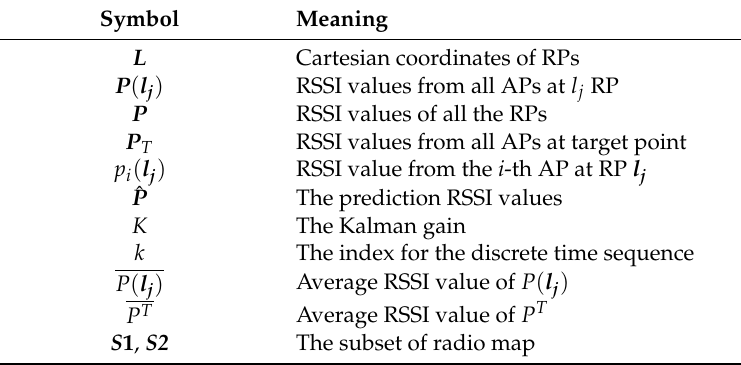
Table 1. Major Symbols Used in Radio